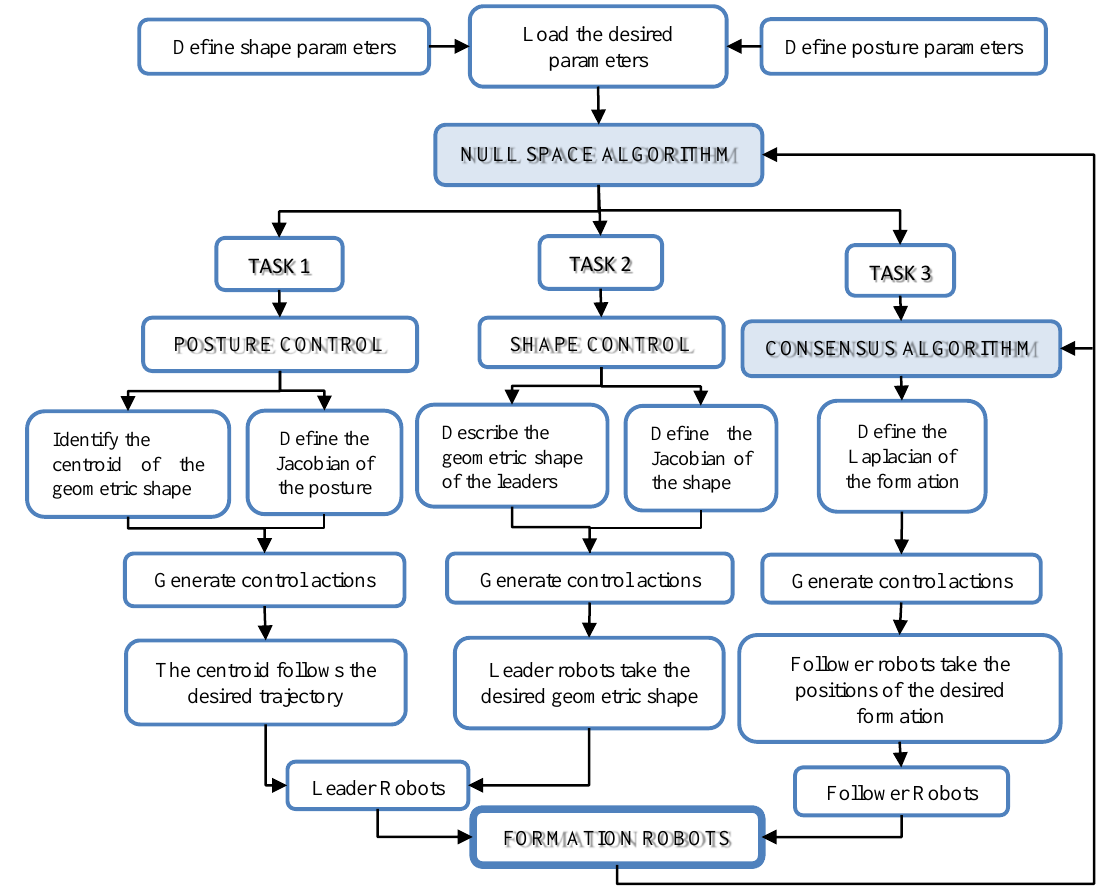
Figure 1. Flowchart of hybrid control